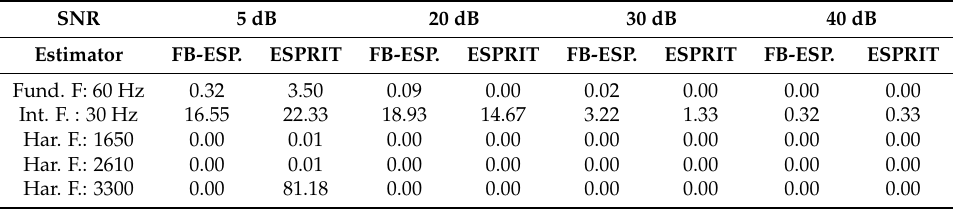
Table 4. Percent error (%) in signal s 1 ( t ) parameters’ estimation in 1000 runs by FB-ESPRIT and